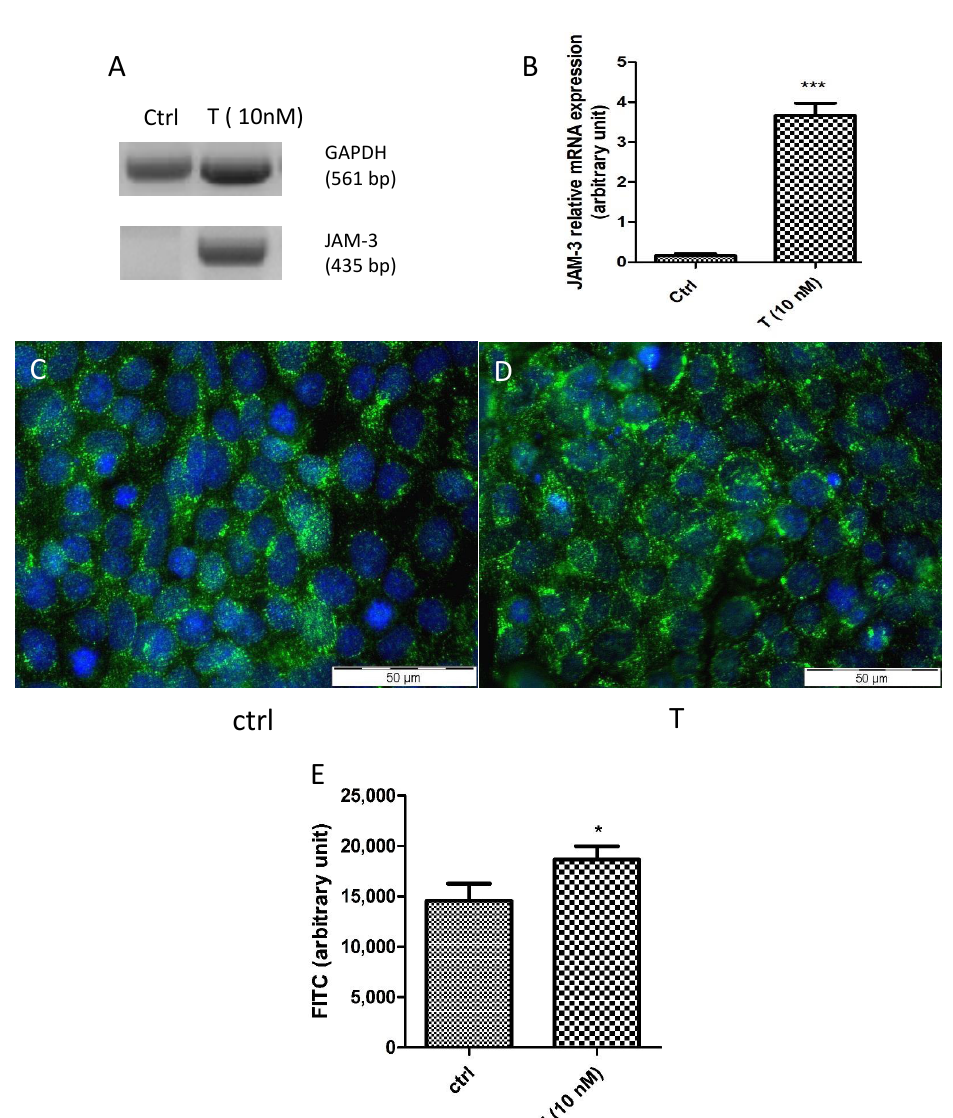
Figure 9. Effects of testosterone (T) on JAM-3 mRNA expression ( A , B ) and protein presence ( C – E ). PASC1 (2 × 10 5 cells/well) were treated with T for 24 h. The JAM-3 mRNA expression was strongly increased in PASC1 after the T treatment compared to the control (ctrl) ( A , B ). JAM-3 is localized mainly in the cell membrane in a punctate pattern but can be also found in the cytoplasm ( C ). T stimulated the JAM-3 protein expression strongly ( D ) and significantly ( E ). DAPI was used to stain the nuclei (blue). Each bar represents the mean ± SEMs of three independent experiments performed in duplicates. The unpaired t -test was used for statistical analysis; * p ≤ 0.05; *** p <